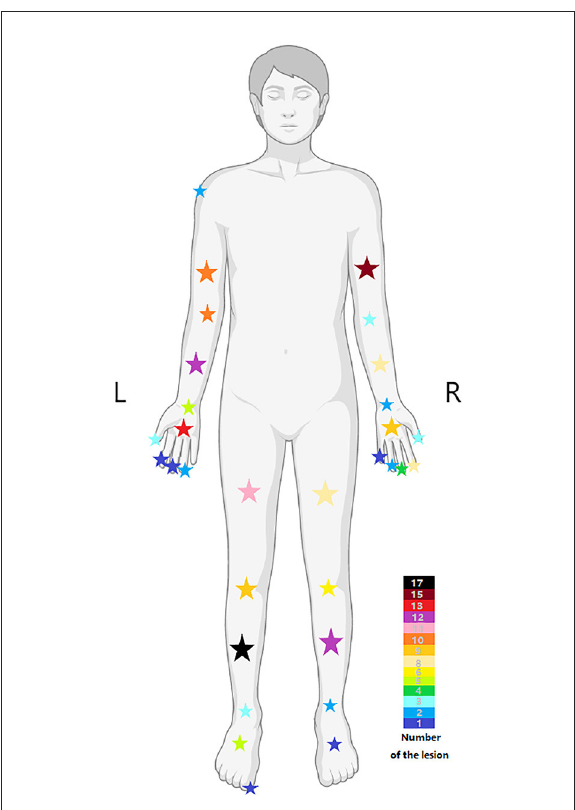
FIGURE5 The distribution of lesions in different body regions, and the color of the stars represents the number of